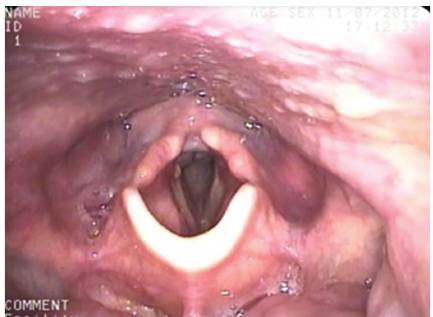
Figure 3: Nasoendoscopy at 5 weeks showed normal supraglottis, epiglottis, and vocal cord